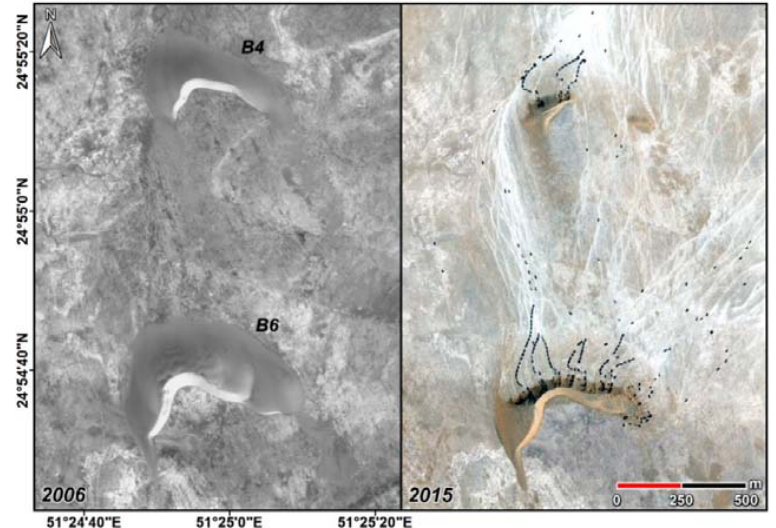
Figure 4. Documentation of sand mining at two dunes of the core study area between 2006 and 2015, as well as associated massive traffic of >100 heavy trucks at a time, which access the NW part of the core study area from the upwind corridor.